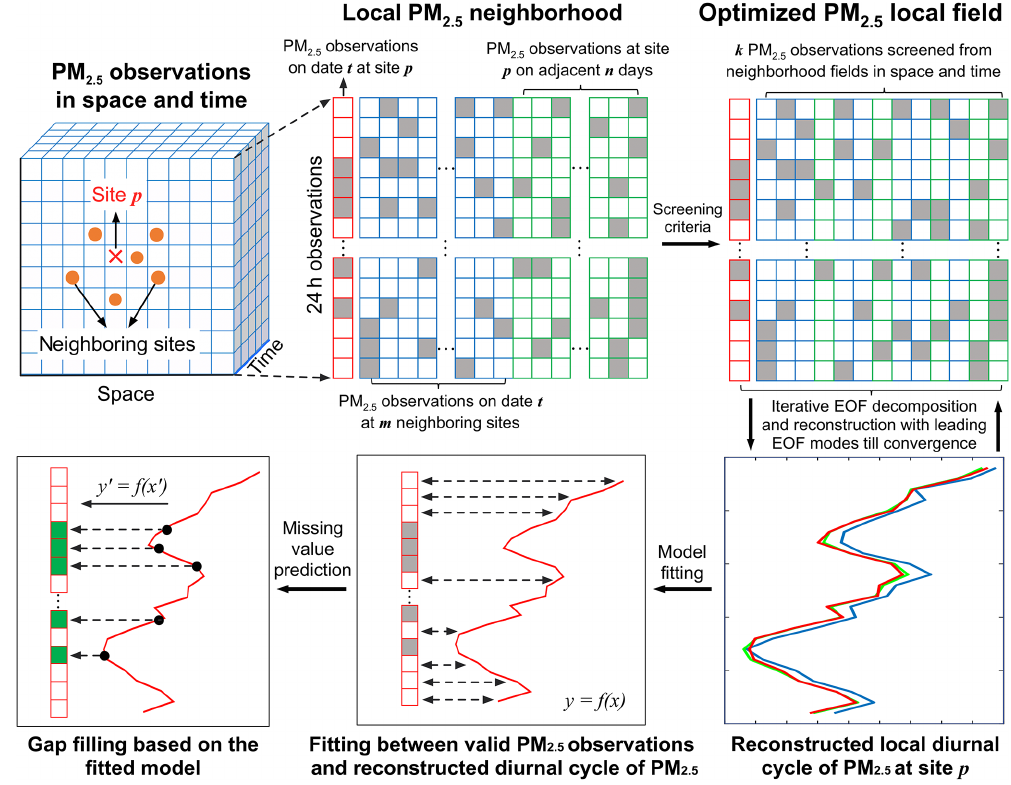
Figure 1. A schematic illustration of the suggested DCCEOF method to fill data gaps in hourly PM 2 . 5 concentration records. The grey squares denote missing values, while the ones outlined in green indicate restored data